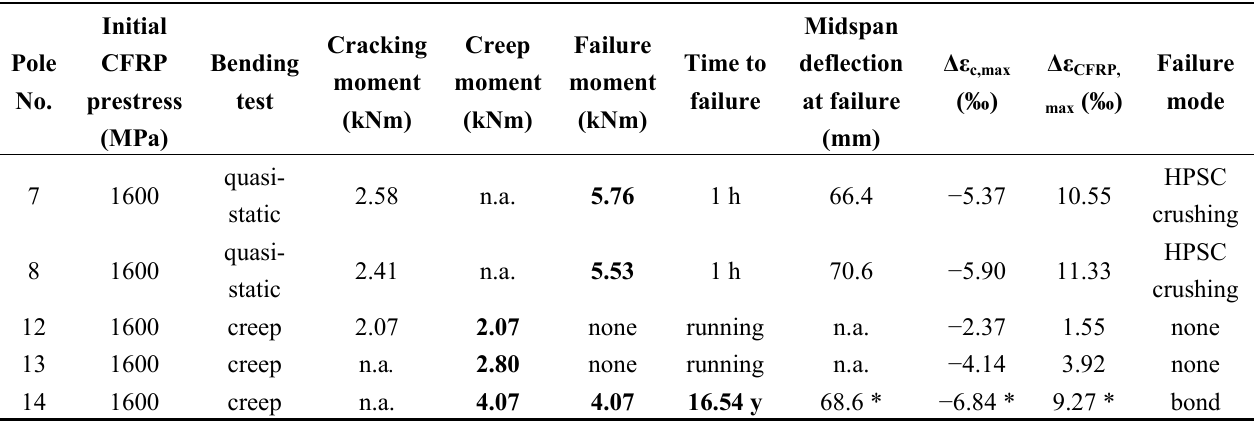
Table 1. Experimental program and main test results (n.a. means “not applicable”, the maximum deflection and maximum strain values for pole No. 14 were last taken 1.4 years before failure *). HPSC, high-performance spun